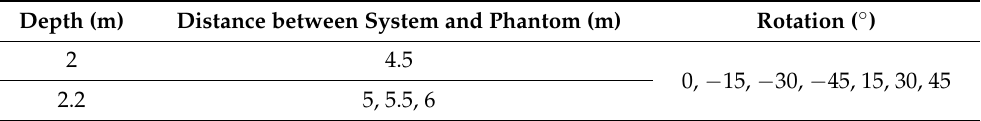
Table 3. Different setup locations of the RGB phantom for acquisition of geometric calibration data. Depth